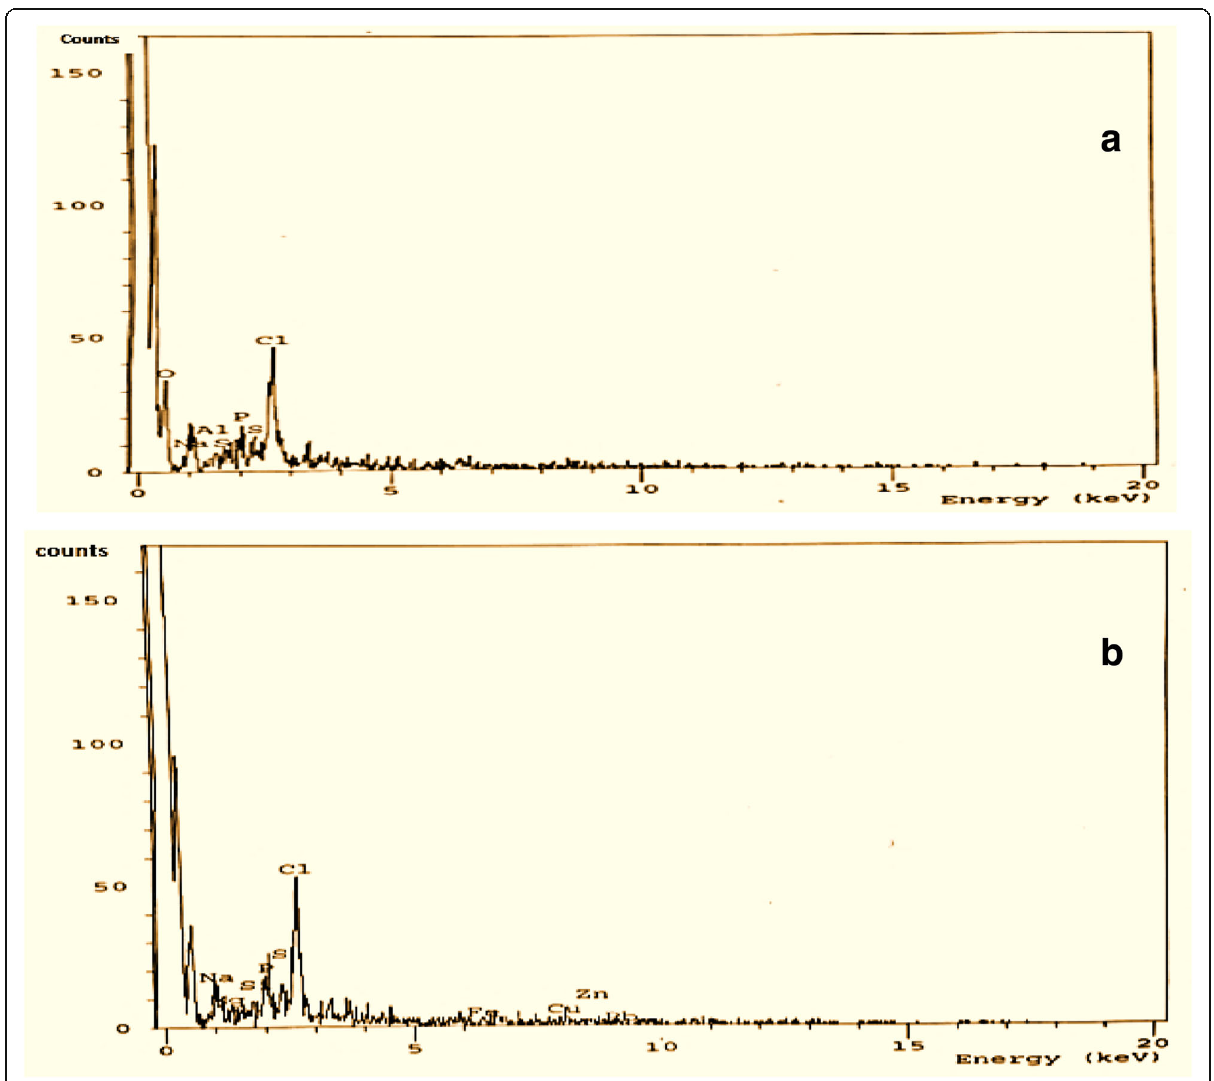
Fig. 9 EDX analysis of native biosurfactant ( a ) and biosurfactant interacted with wastewater ( b